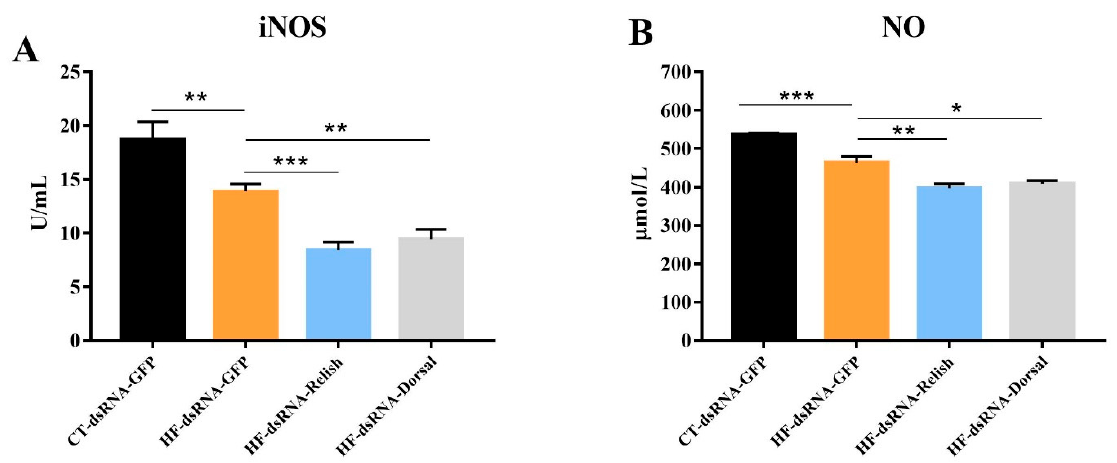
Figure 9. Hemolymph iNOS activity and NO content of Macrobrachium rosenbergii after knock-down by dsRNA-mediated RNA interference. ( A ) Hemolymph inducible nitric oxide synthase (iNOS) activity of M. rosenbergii after RNA interference; ( B ) Hemolymph nitric oxide (NO) content of M. rosenbergii after RNA interference. Values are means ± SEM. ***: p < 0.001, **: p < 0.01, *: p < 0.05.